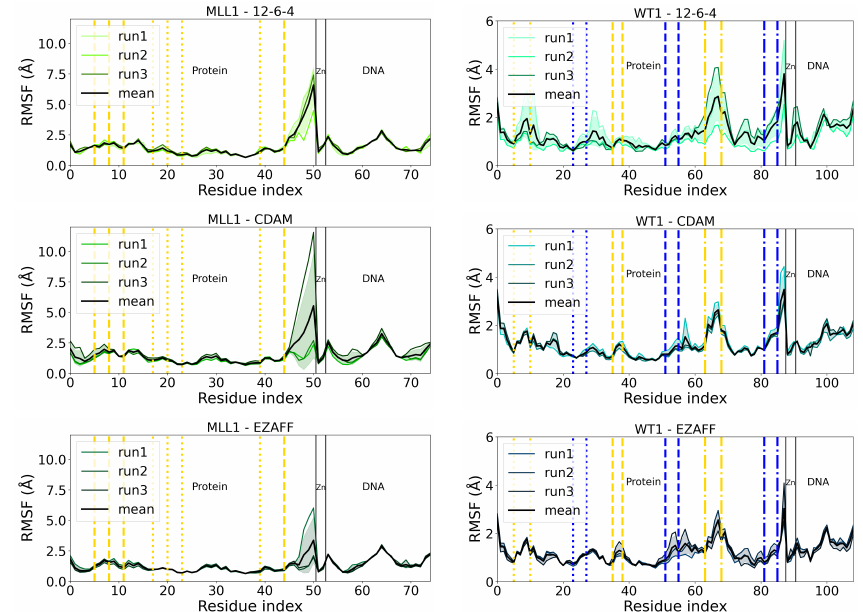
Figure 3. RMSF of C α (protein, residue indices 0–50 and 0–87 for MLL1 and WT1, respectively), Zn 2 + (residue indices 51–52 and 88–90 for MLL1 and WT1, respectively) and P (DNA, residue indices 53–74 and 91–108 for MLL1 and WT1, respectively) atoms after aligning to the median structure of the same atoms for MLL1 and WT1, respectively, simulated with the different zinc models. The standard deviation of the mean is shown in the transparent shade. Coordinating cysteines are shown in yellow and histidines in blue. The residues coordinating ZN1, ZN2, and ZN3 are indicated as dotted, dashed, and dash-dotted lines, respectively. Black vertical lines are added for visually separating protein, Zn 2 + -ions, and DNA. For residue names of coordinating residues see Table